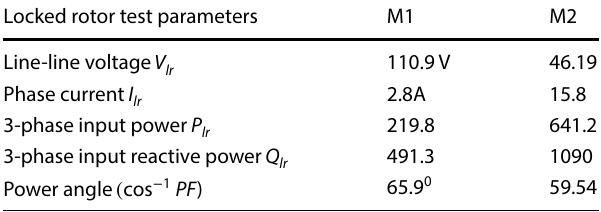
Table 6 IM Locked-rotor test simulation